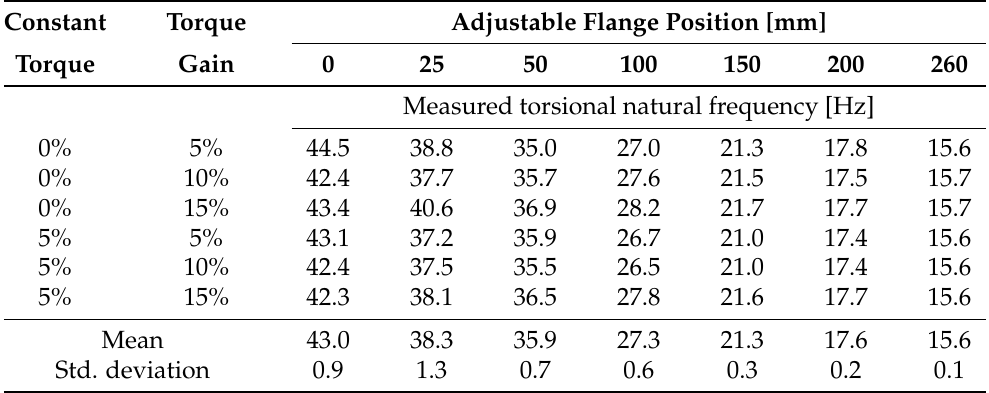
Table 3. The torsional natural frequencies measured using different excitation magnitudes. Gain is the torque magnitude of the PRBS excitation and constant torque is the magnitude of constant torque opposing the rotation of the powertrain. Torque magnitudes are presented as percentages from the maximum motor torque of 236 N · m.